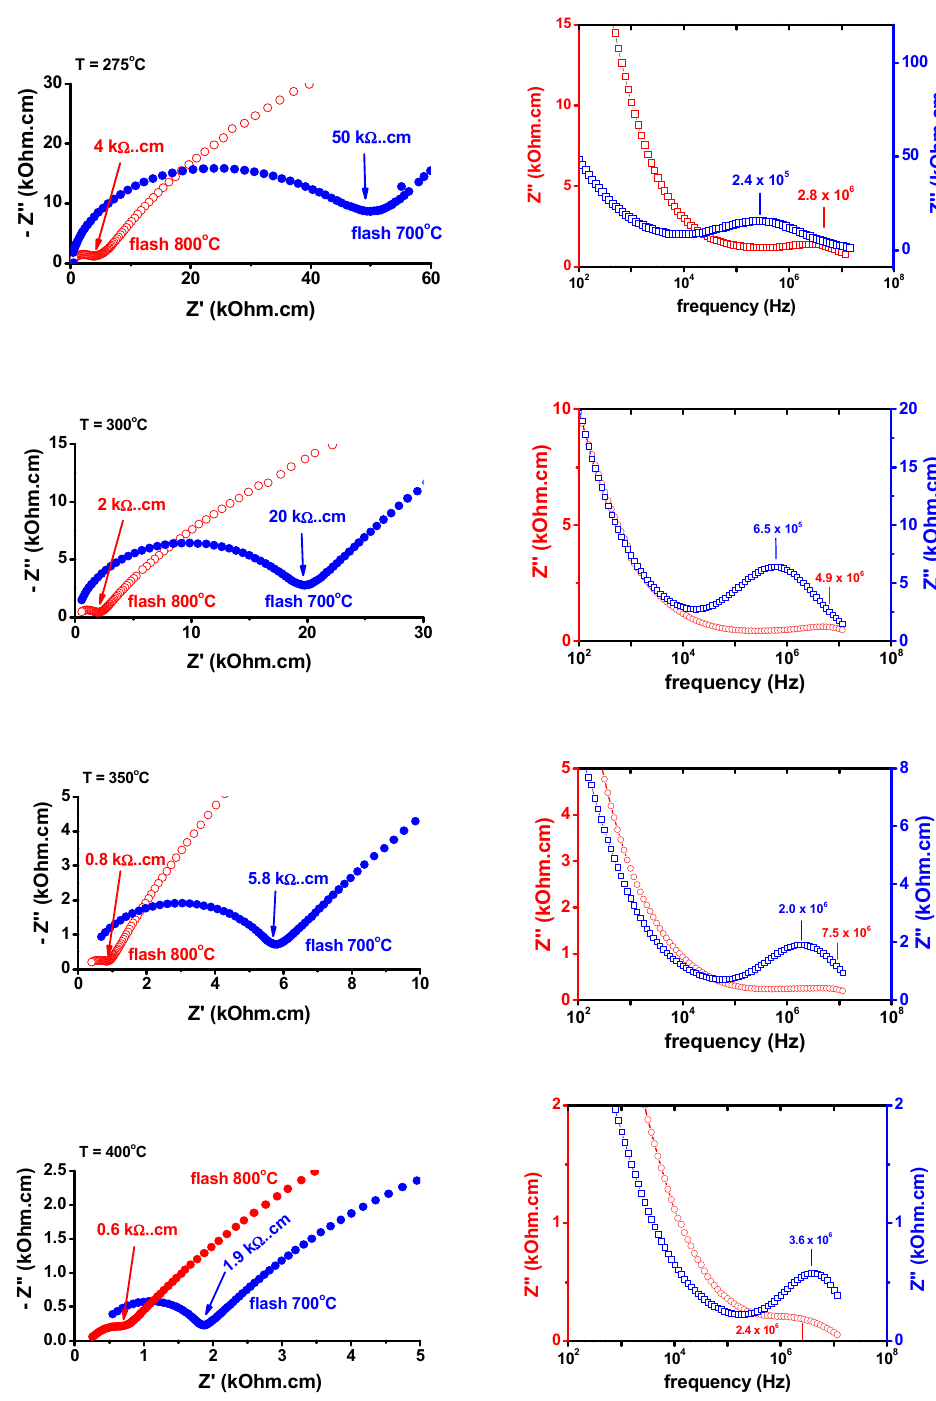
Figure 5. Impedance spectroscopy diagrams ( left ) and Bode diagrams ( right ), with data collected at 275 ◦ C, 300 ◦ C, 350 ◦ C, and 400 ◦ C, of BITIVOX samples flash sintered at 700 ◦ C / 5 min and at 800 ◦ C / 5 min. Bulk resistivity values are shown in the left figures. Maximum frequencies in the right